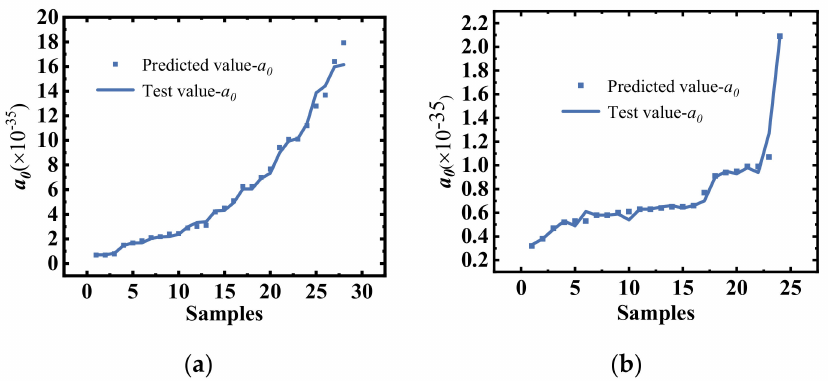
Figure 10. Comparison of the predicted values from the DNN impact ionization coefficient model with test values derived from the TCAD simulation tools: ( a ) when the drift region is fully depleted and ( b ) when the drift region is not fully